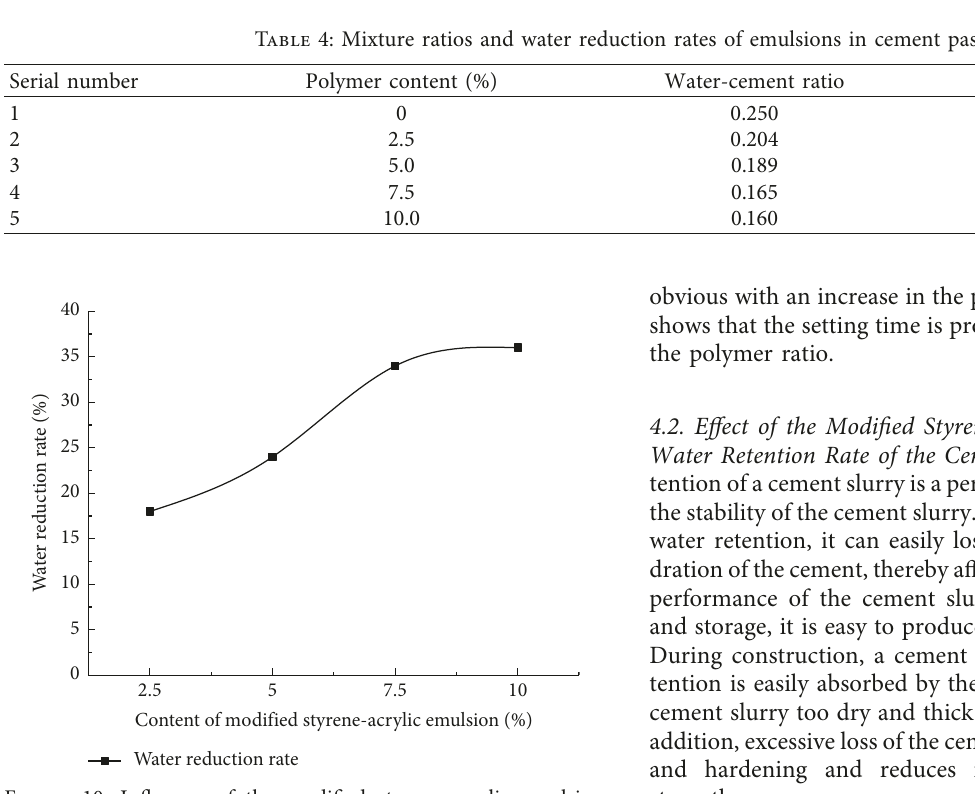
Figure 10: Influence of the modified styrene-acrylic emulsion content on the water reduction rate of the cement slurry.